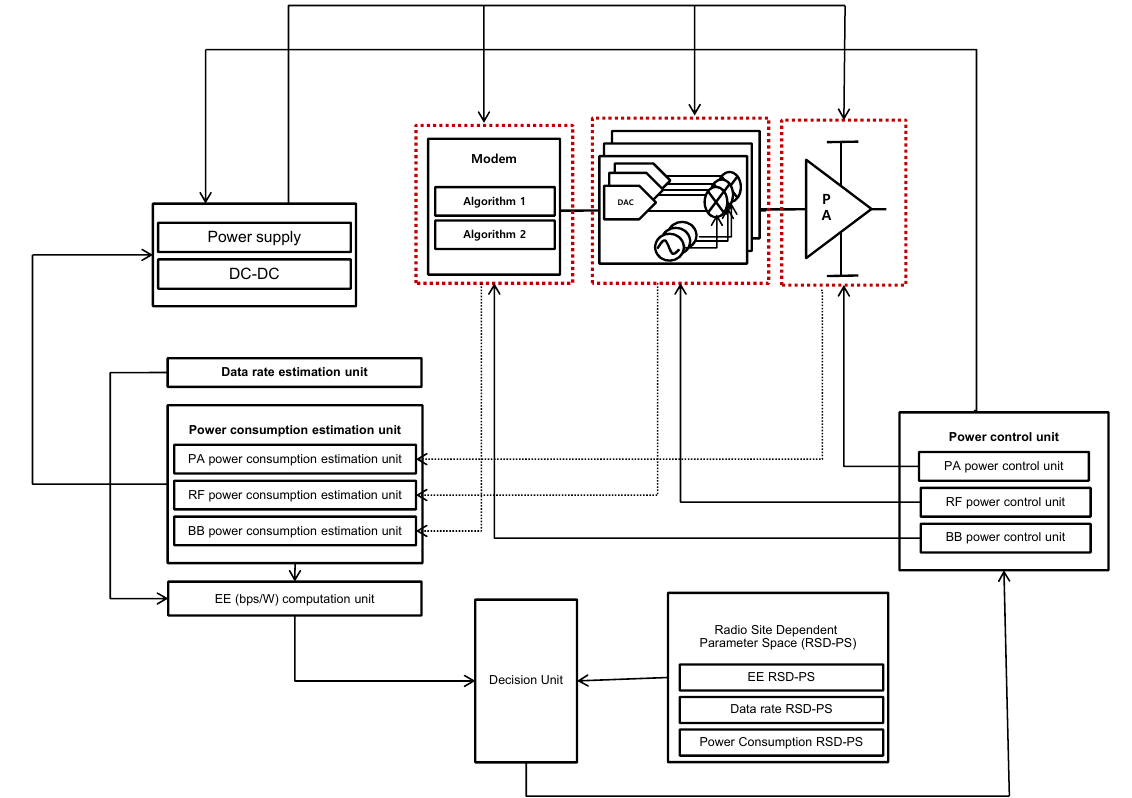
Figure 7. Reference BS structure used in the performance analysis.